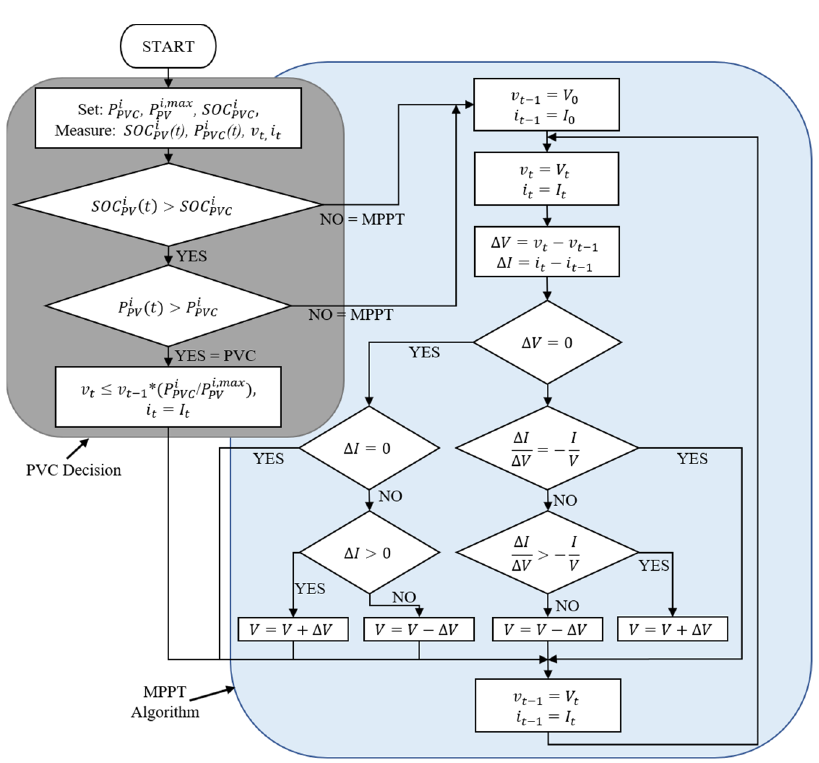
Figure 3. MPPT algorithm, including a PV curtailment function.